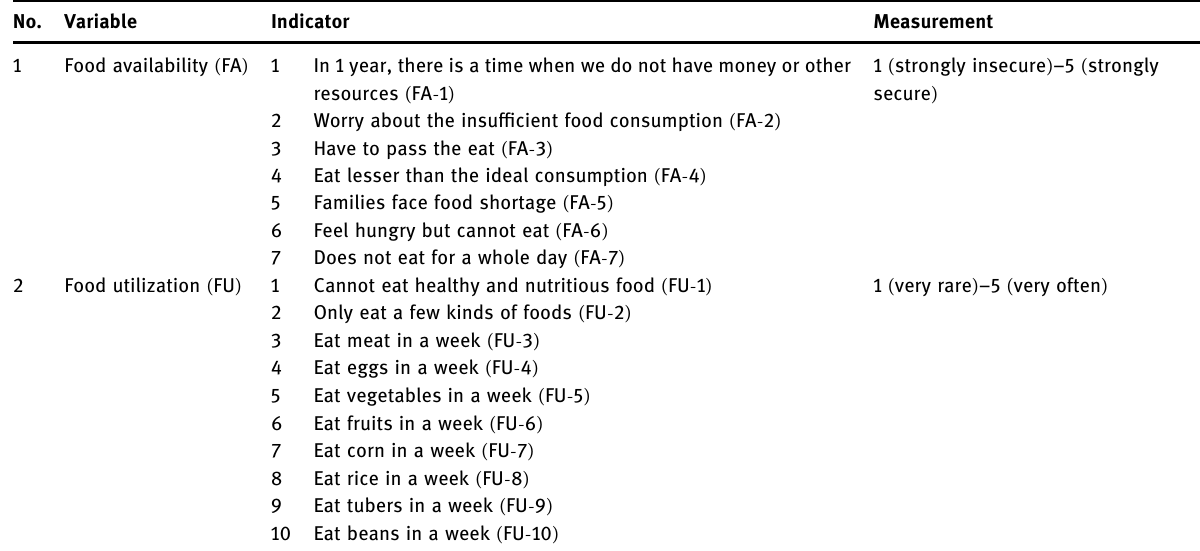
Table 2: Variables and indicators No.